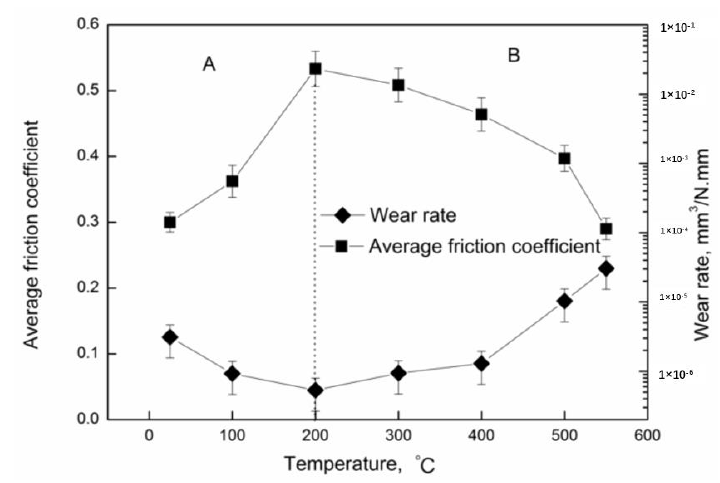
Figure 4. Friction coefficient and wear rate of Mo 2 N film as a function of testing temperatures.